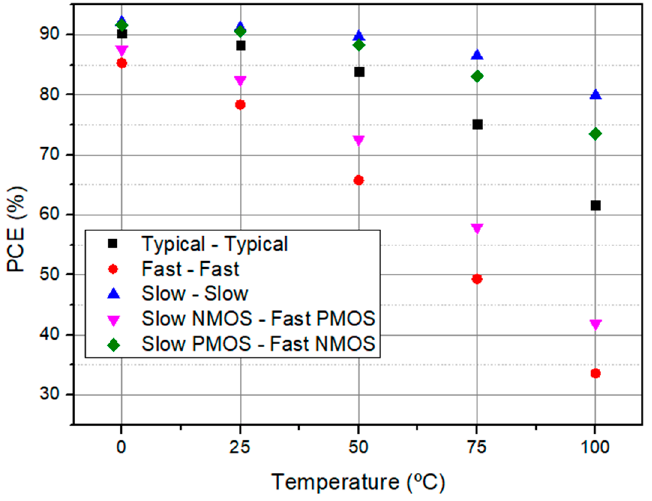
Figure 10. PCE variation with temperature depending on the process corner variation for a R LOAD =